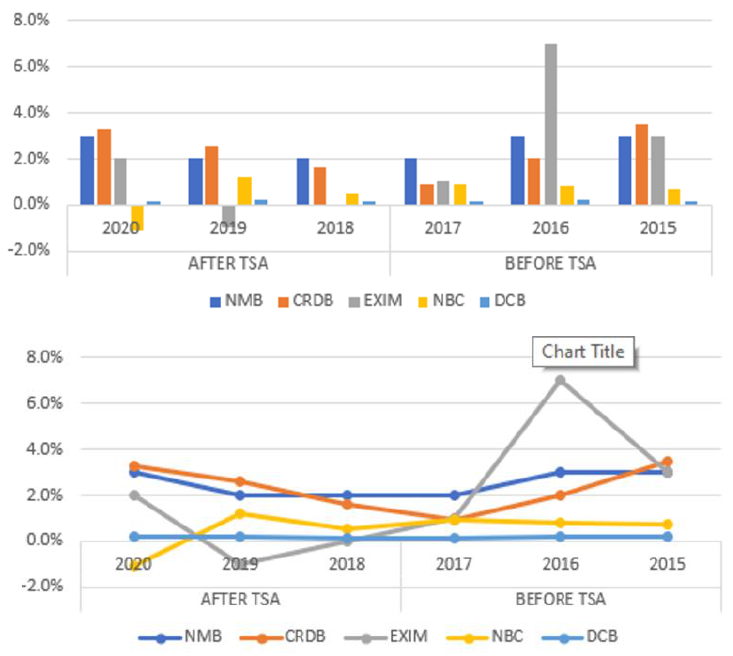
Figure 3: Earning Ability of the Commercial Banks (ROA); Source: Author’s Compilation, 2021; Source: Author’s Compilation, 2021